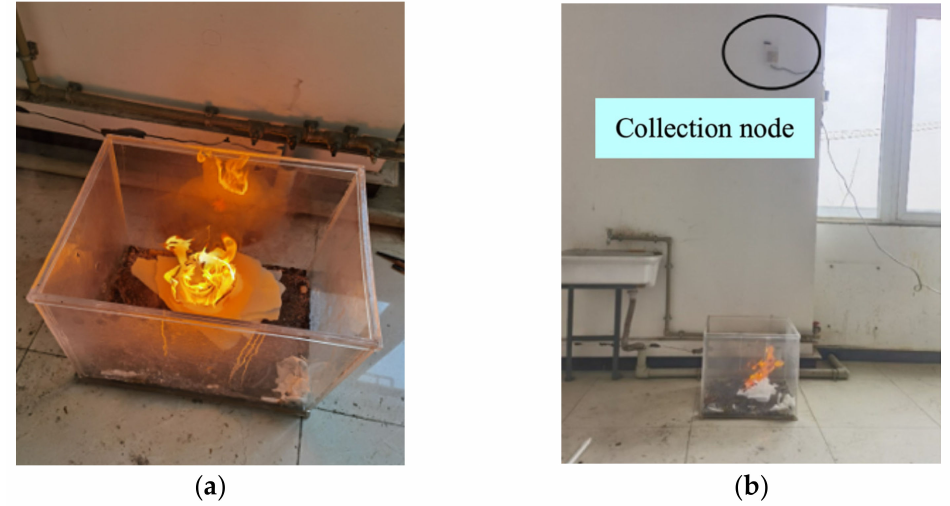
Figure 13. The polyurethane fire test: ( a ) the process of polyurethane combustion; ( b ) the fire